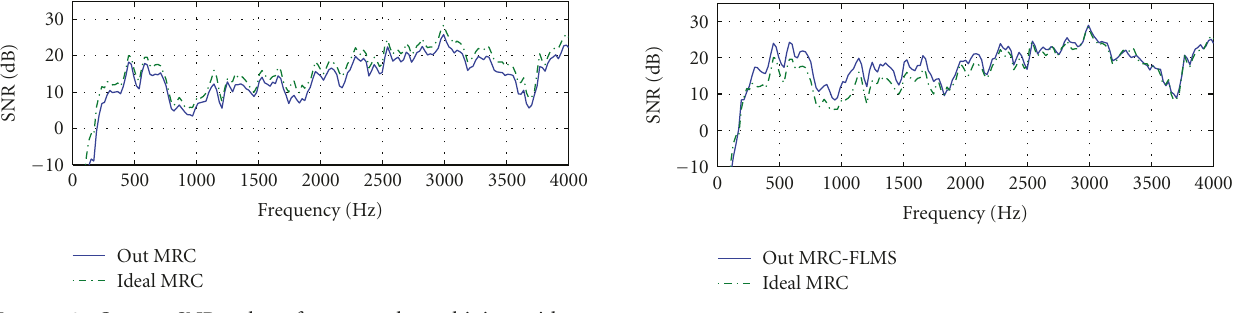
Figure 10: Output SNR values for the combined approach with additional noise suppression (car speed of 100 km/h, ρ = 10).